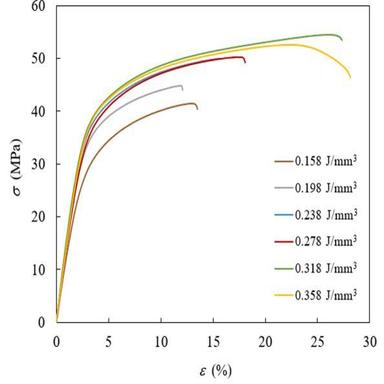
True stress-strain curves of SLS test specimens depending on EDV.